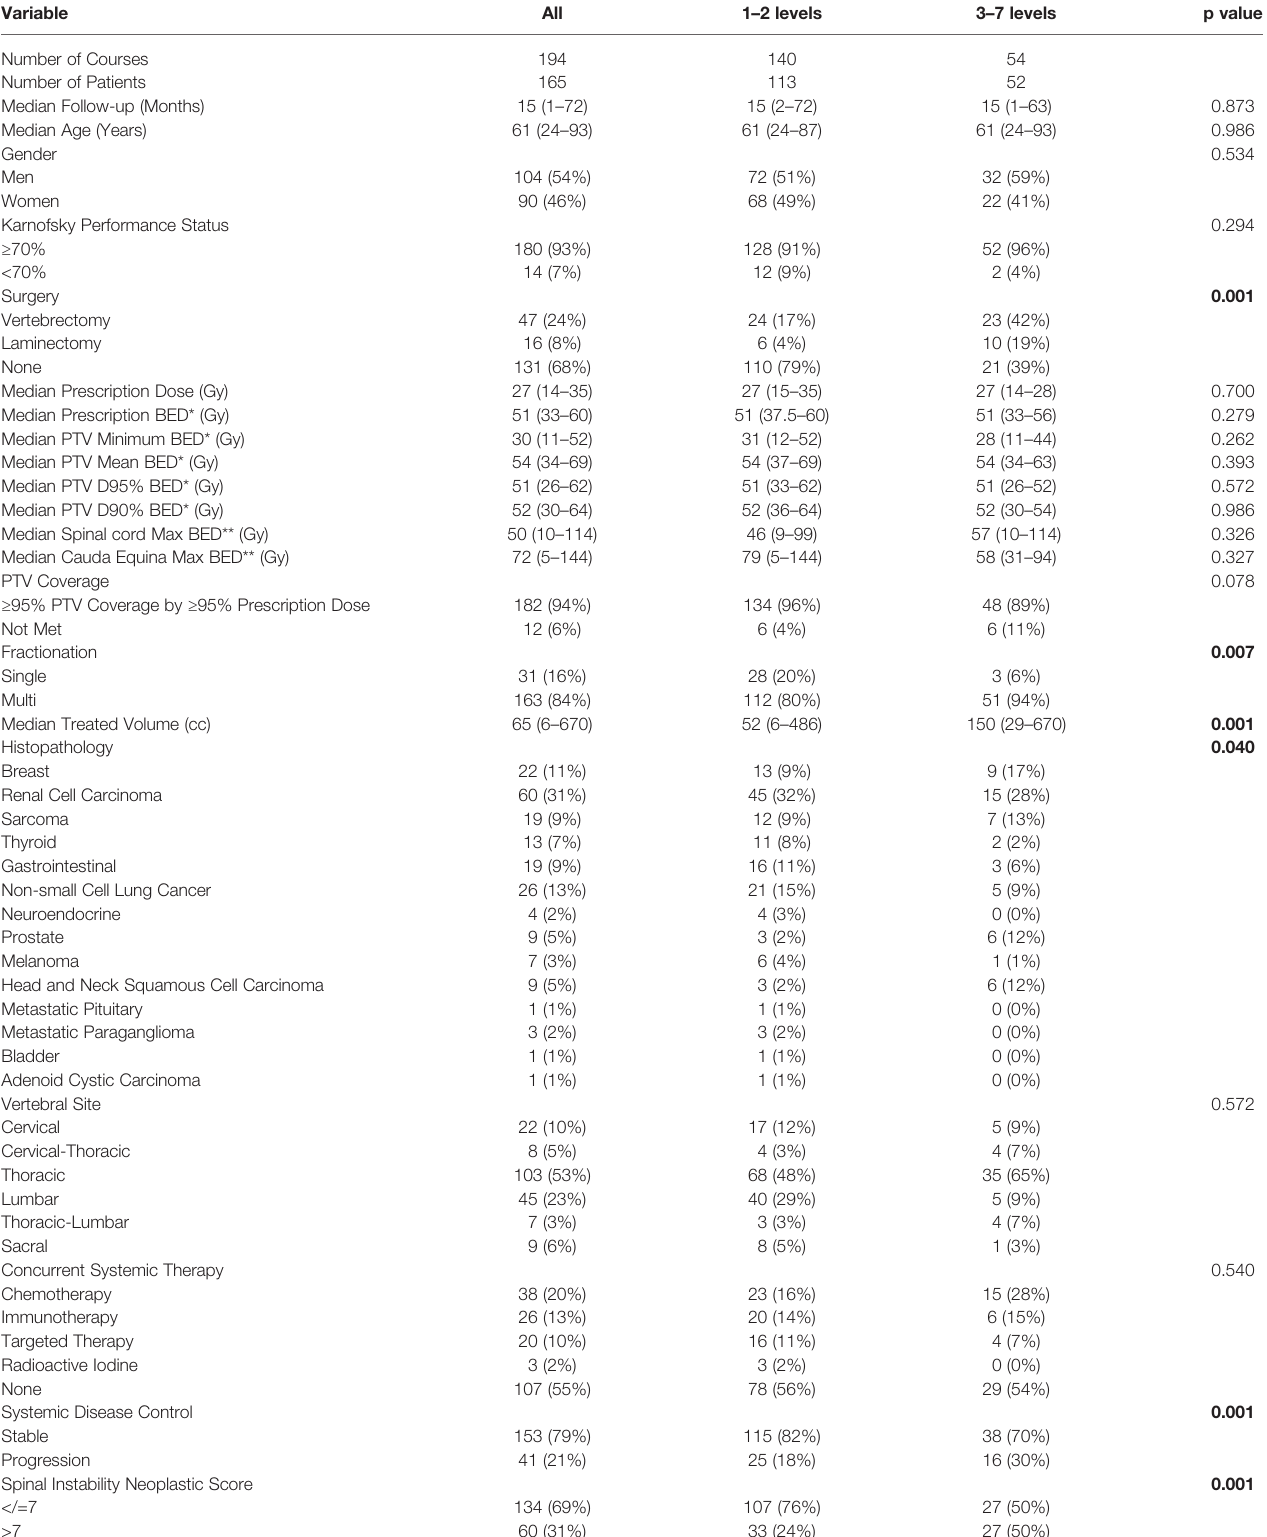
TABLE 1 | Patient demographic and treatment characteristics strati fi ed by the number of contiguous treated spinal